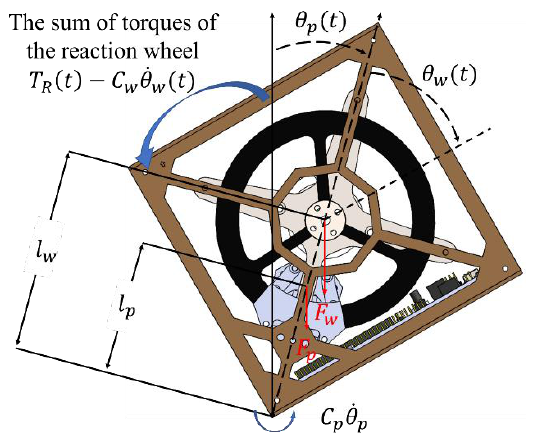
Figure 4. The torque and rotation angle of the cube robot.